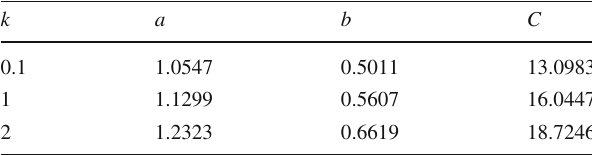
Table 1 Values of the model parameters for different choices of k for a hypothetical charged compact star of mass M = 1 . 58 M (cid:7) and radius R = 9 . 1 km